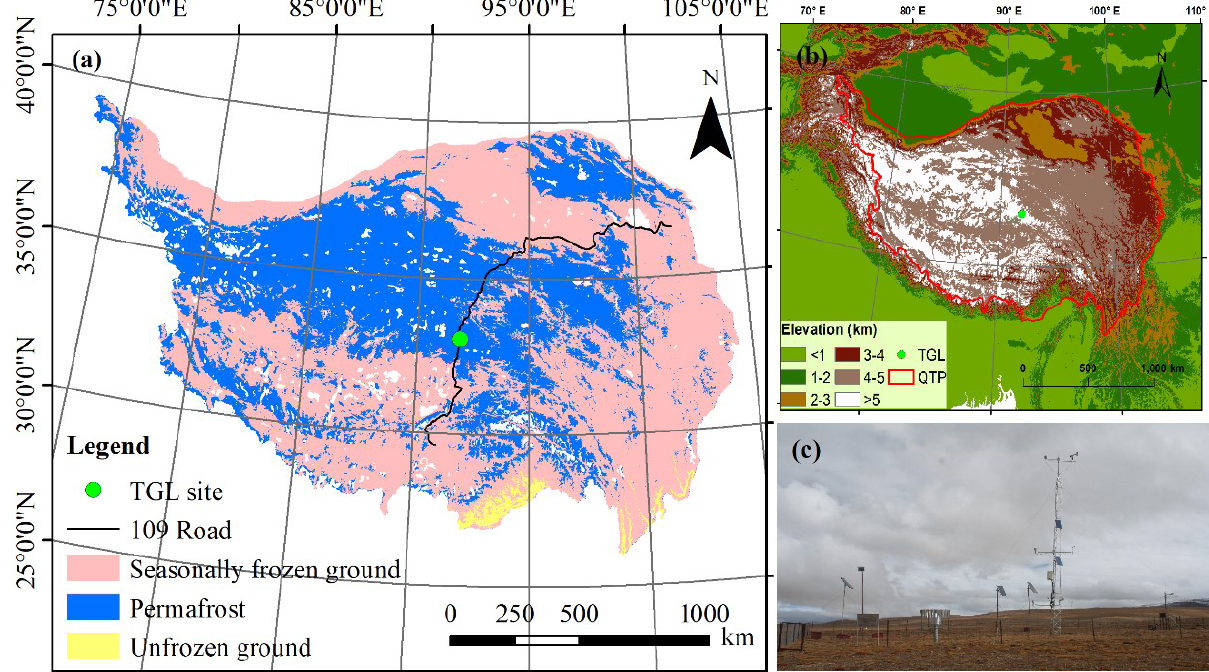
Figure 1. Location and geographic features of the study site. (a) Location of the observation site and permafrost distribution (Zou et al., 2017). (b) Topography of the Qinghai–Tibet Plateau. (c) Photo of the Tanggula observation station.